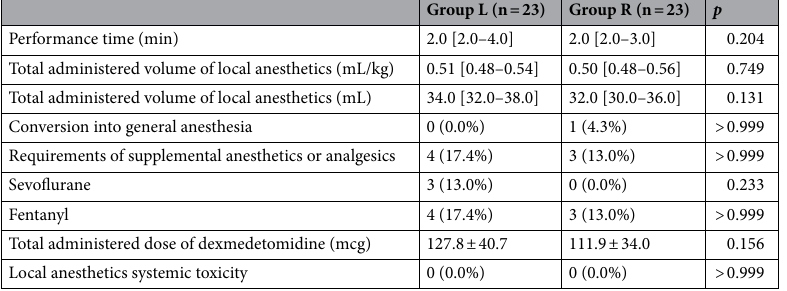
Table 3. Block performance details and outcomes of the block. Data are presented as mean ± standard deviation, median [interquartile range], or number (%).